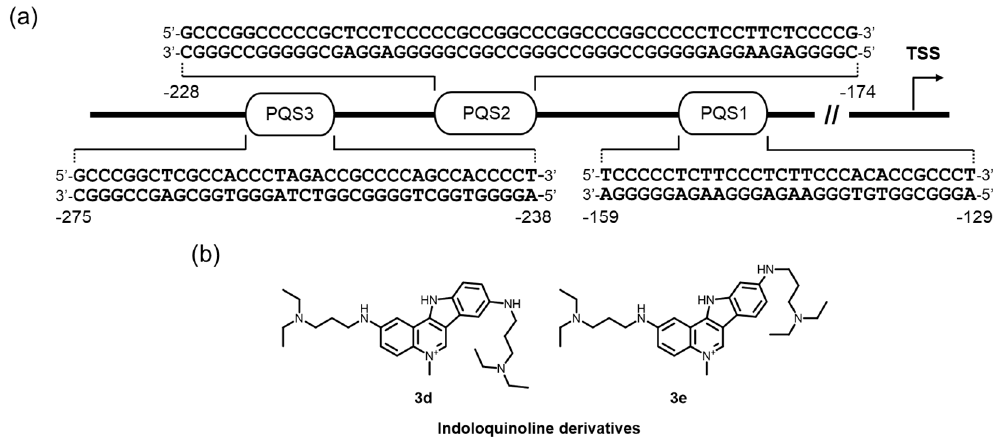
Figure 8. ( a ) The human KRAS promoter has three PQSs. In particular, the G4 formation at the most proximal PQS (PQS1) is shown to act as a stronger transcriptional repressor. ( b ) Molecules interacting with its G4 DNA and causing antitumor